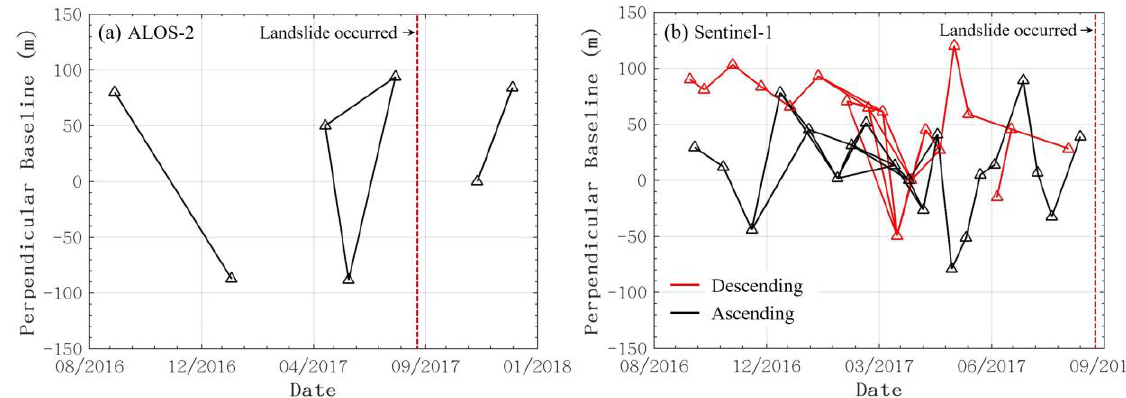
Figure 4. Baseline configurations of interferograms for ALOS/PALSAR-2 and Sentinel-1A/B SAR images. Triangles and lines represent SAR acquisition dates and interferograms, respectively. Red dash line indicates the date when the Pusa landslide occurred. ( a ) ALOS/PALSAR-2 interferograms. ( b ) Sentinel-1A/B interferograms.